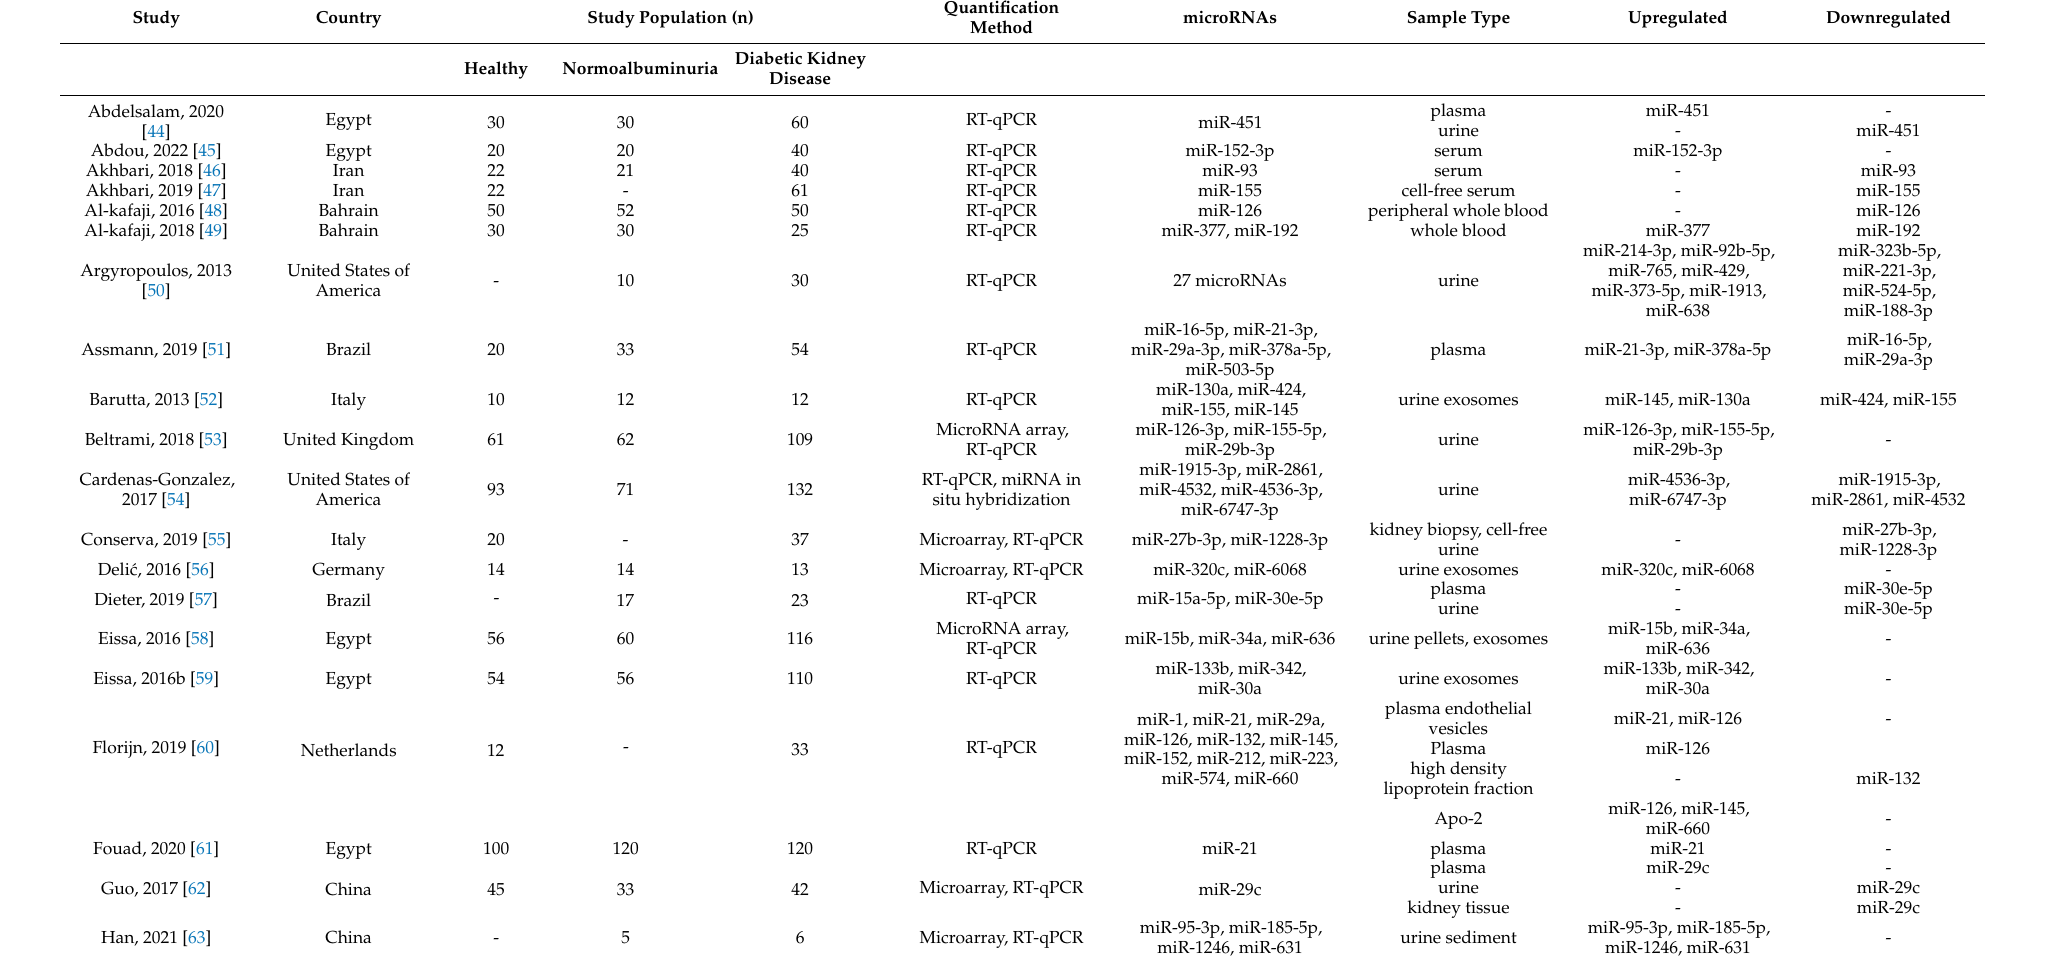
Table 2. Characteristics of studies evaluating microRNA expression patterns in diabetic kidney